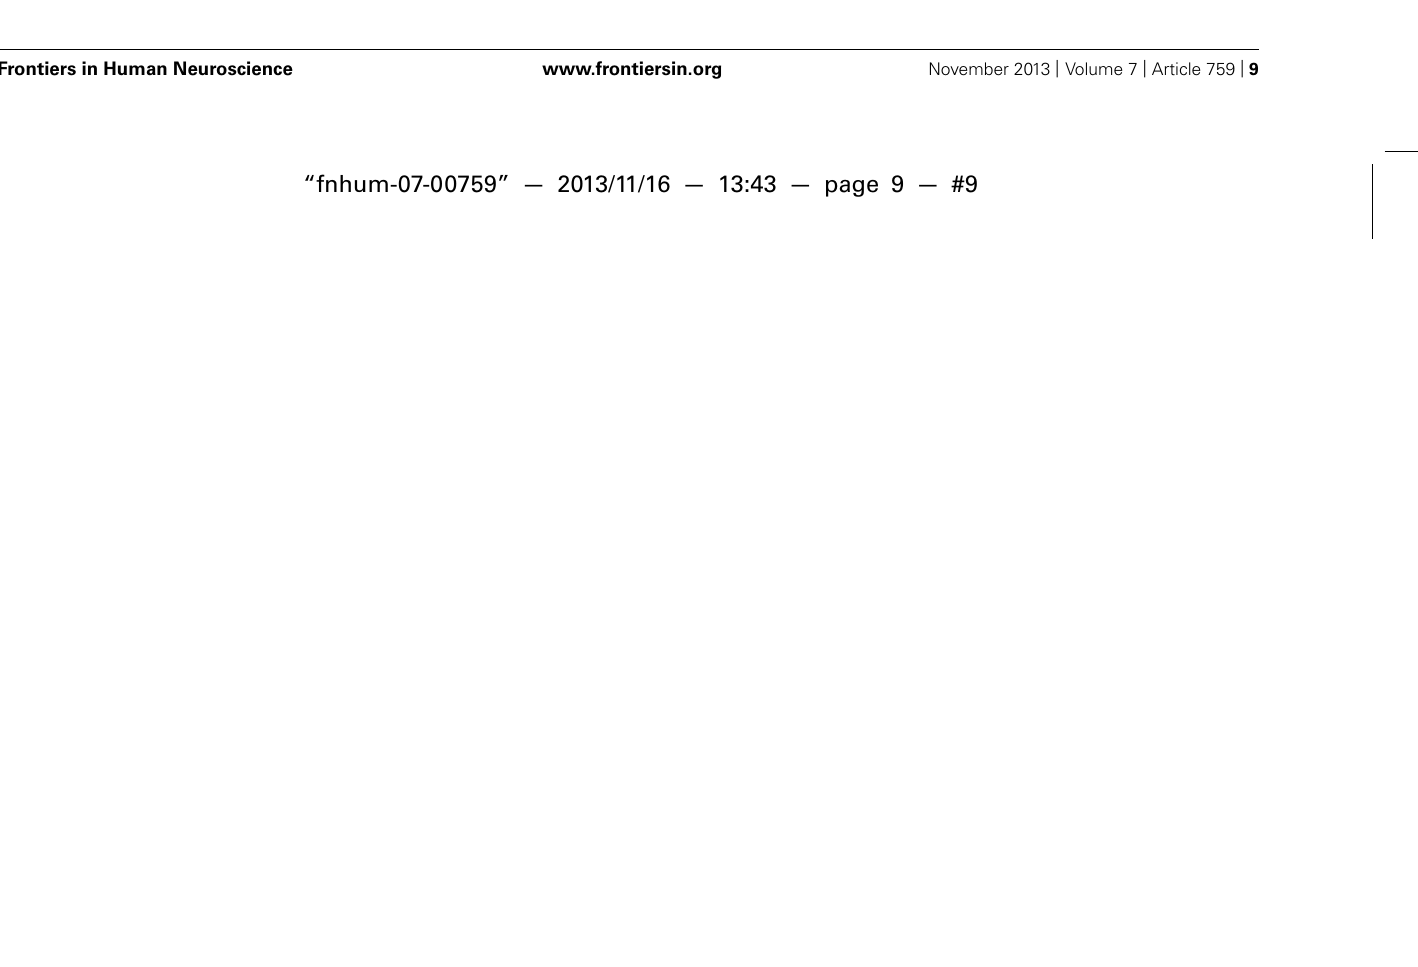
in left posterior STG ( F ( 1,14 ) = 11.35, p < 0.005). In the